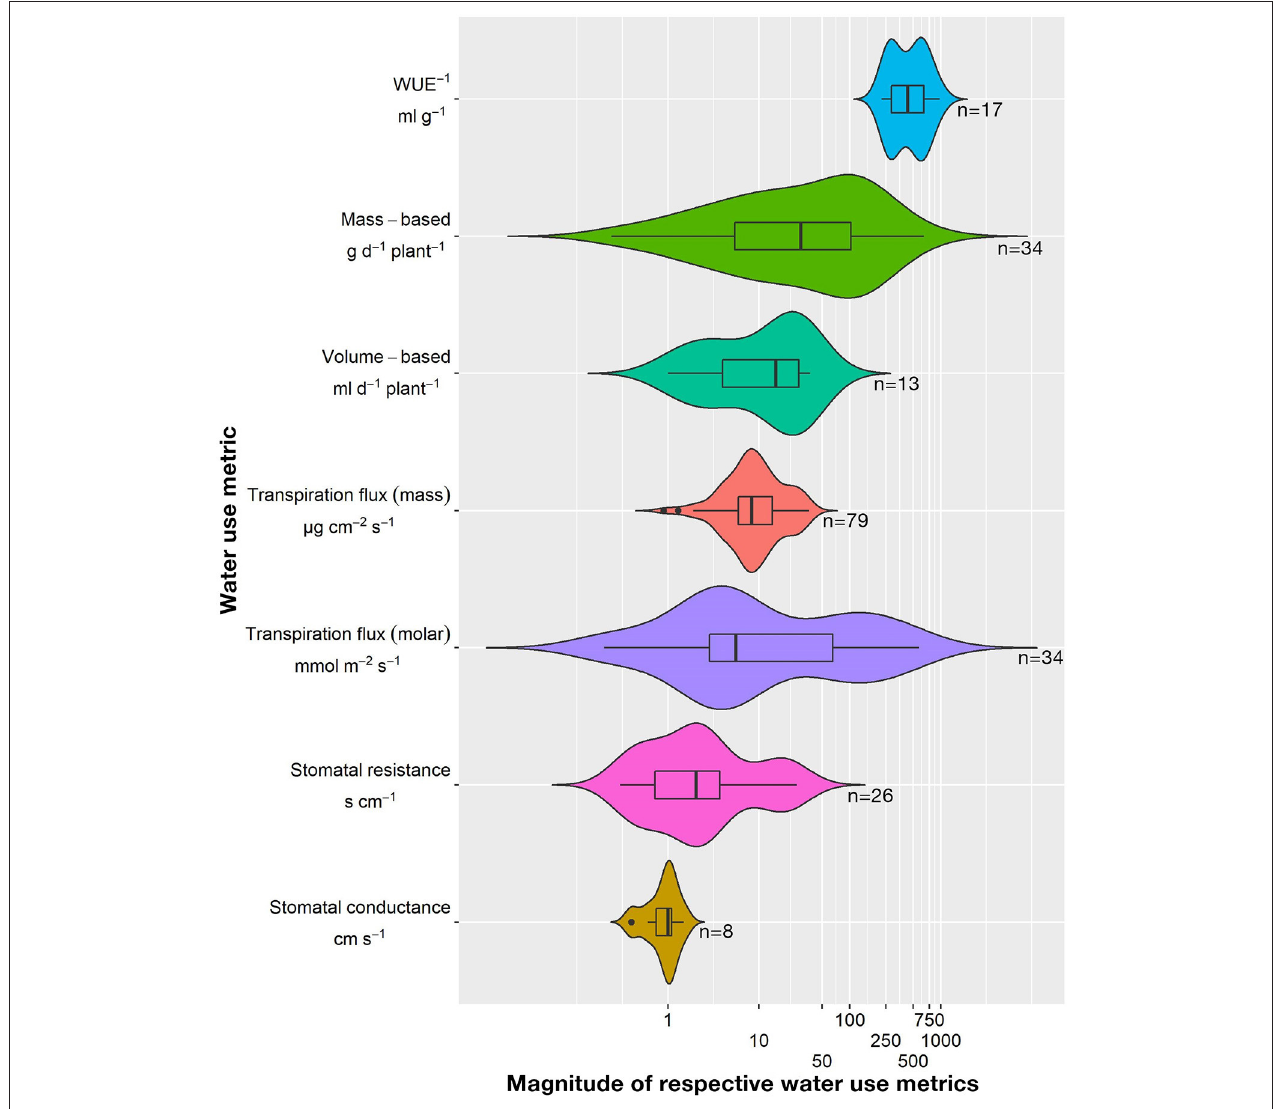
FIGURE 5 | Violin plot with overlay of boxplots of eight water use (WU) estimates reported in the literature. The outline of the violin plot represents the distribution shape of the data. The x-axis of the violin plot has been transformed to log 10 scale for better visualization. The bold black central line of the boxplot represents the median, the box represents the interquartile range, and the whiskers extend up to the minimum and maximum values excluding the outliers.